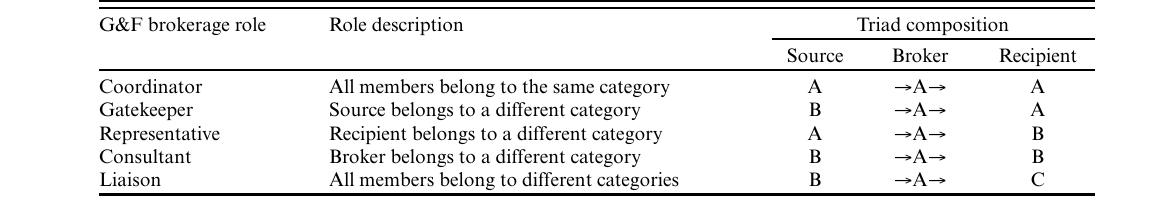
Table 2 . Gould and Fernandez (G&F) brokerage role